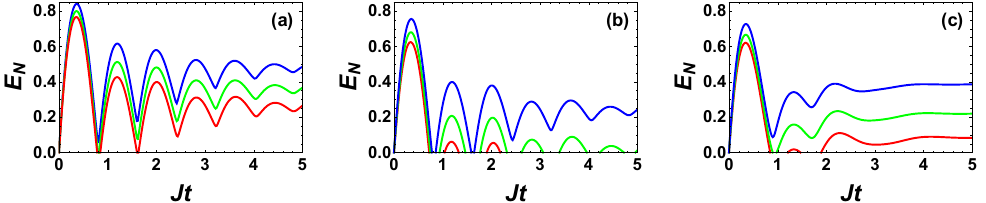
Figure 3. Time evolution of the logarithmic negativity for various saturation intensities in a cou- pled gain–loss waveguide system. We use the input states as single-mode squeezed vacuum with squeezing parameters r 1 and r 2 and phase factors θ 1 and θ 2 . We set the parameters as r 1 = r 2 = 0.5, θ 1 = θ 2 = 0, G 0 = g 0 / J = 0.8, E 0 / J = 0, G ( t ) = G 0 / ( 1 + I a ( t ) / I sat ) , and I sat = 0.1 (red), 0.07 (green), and 0.04 (blue). The loss rate is set to γ / J = 0.4 in ( a , b ) and γ / J = 0.8 in ( c ). In ( b , c ), we change the initial gain rate to G 0 =